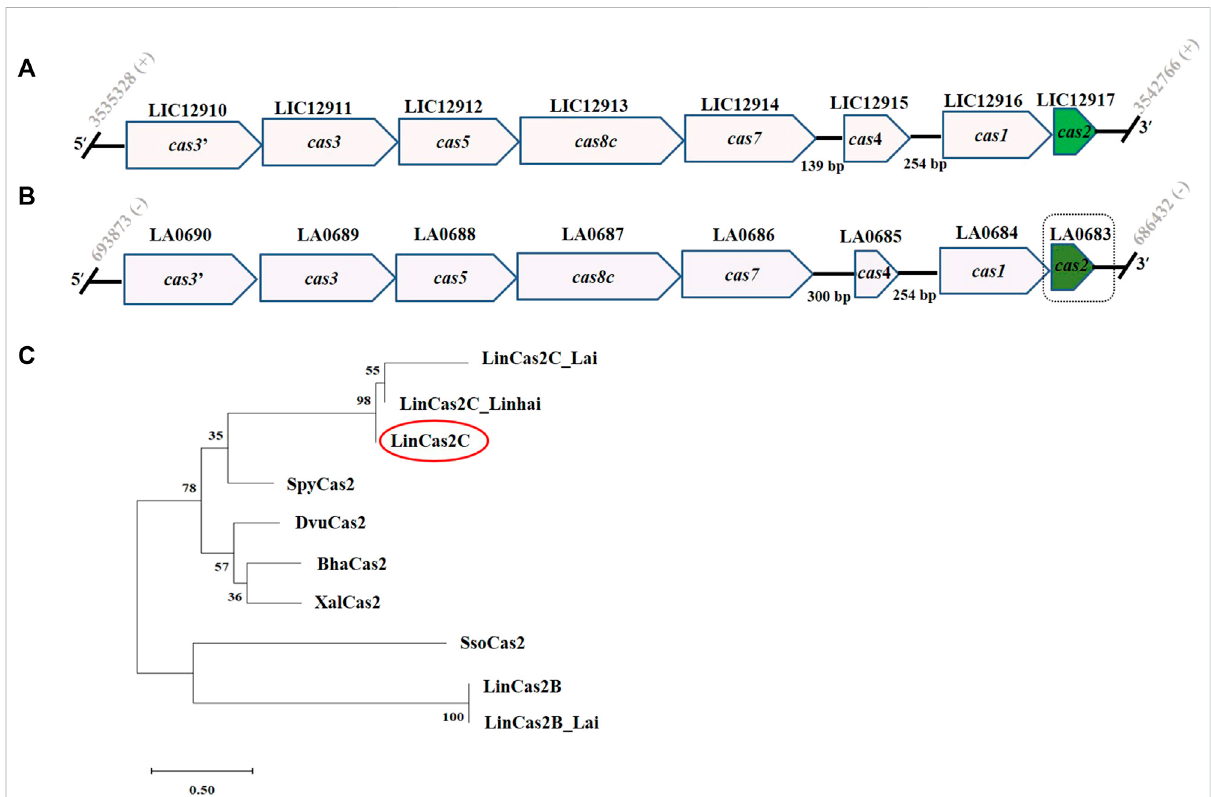
FIGURE 1 CRISPR-Cas I-C locus of L. interrogans and molecular phylogeny of Cas2C orthologs. (A,B) Schematic representation of the architecture of CRISPR-Cas I-C of serovar Copenhageni and Lai, respectively. (C) Phylogenetic analysis of Cas2 orthologs generated by way of the maximum likelihood algorithm. L. interrogans serovar Copenhageni Cas2B and Cas2C are represented as LinCas2B and LinCas2C, respectively. Similarly, in parenthesis, Cas2C of L. interrogans serovar Lai (LinCas2C_Lai), Streptococcus pyogenes (SpyCas2; Q99YS8), Xanthomonas albilineans (XalCas2; D2UG58), Bacillus halodurans (Bha_Cas2; Q9KFX8), Desulfovibrio vulgaris (DvuCas2; Q72WF4) and Sulfolobus solfataricus (SsoCas2; Q97YC2) are shown. + and − sign represents sense and anti-sense strands,